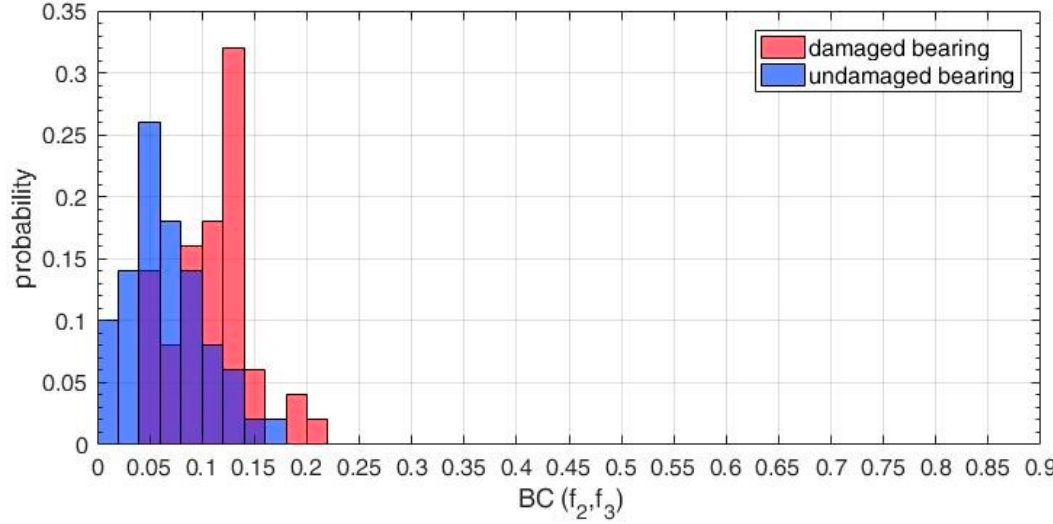
Figure 6. The histograms of the magnitudes of bicoherence (BC) for 5 s time window.